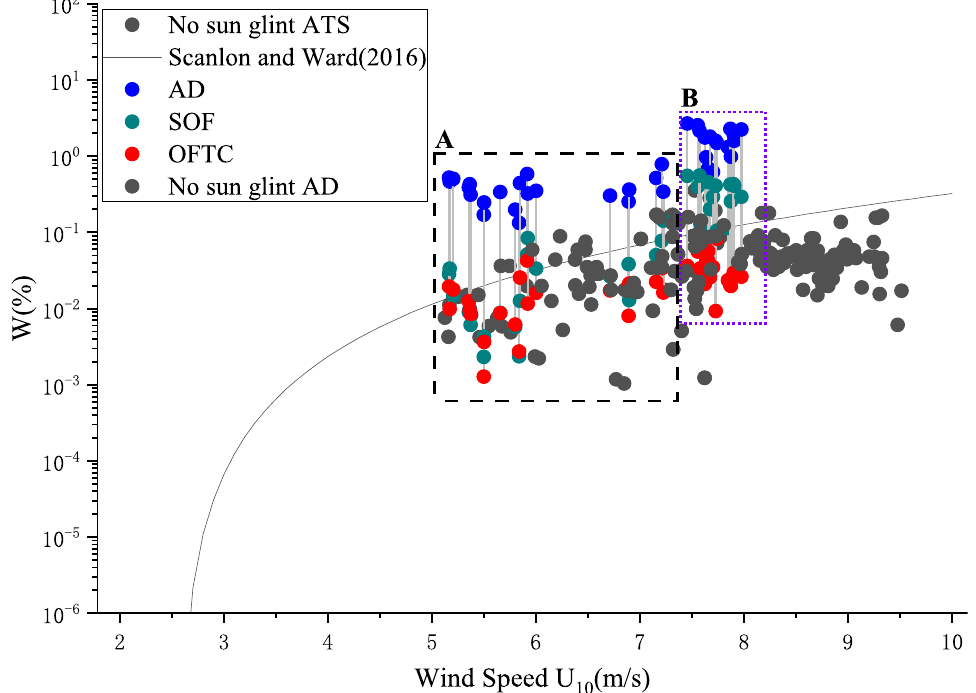
Figure 18. W obtained by different methods. No sun glint ATS represents W obtained using the ATS method without light pollution, no sun glint AD represents W obtained using the AD we proposed without light pollution, AD represents W obtained by whitecap extraction method using only a single image, SOF represents W obtained by single optical flow method, and OFTC represents W obtained by the optical flow trajectories correlation